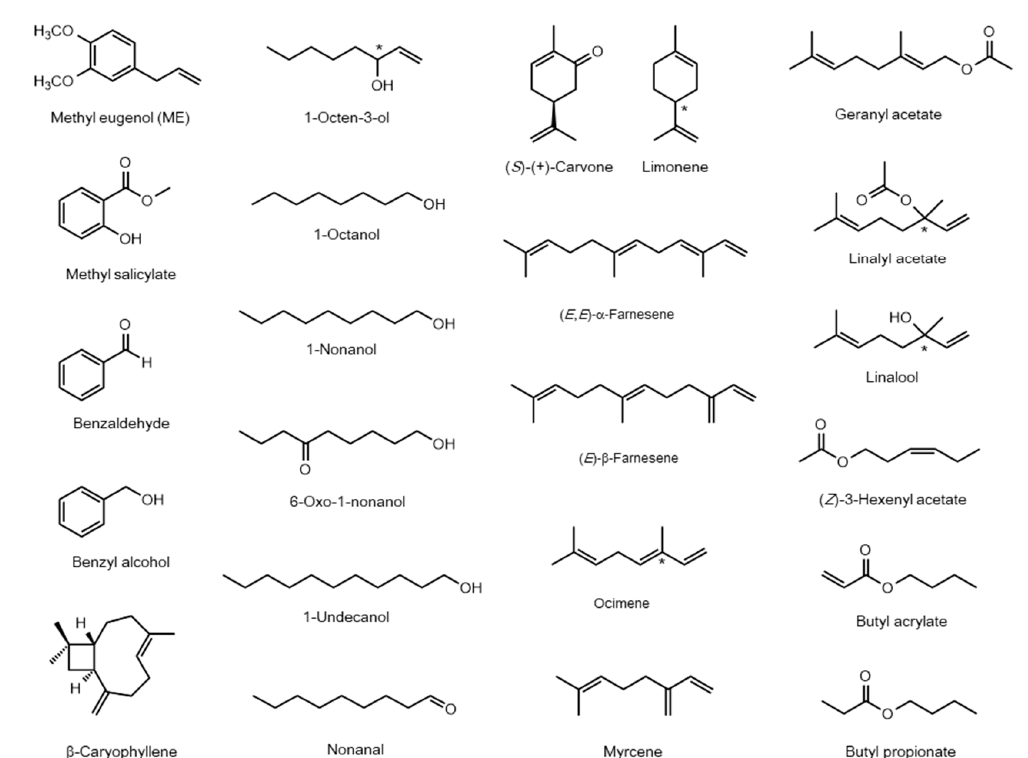
Figure 2. Structures of ligands for odorant biding proteins and olfactory receptors presented in Tables 1 and 2. Stereocenters are shown by asterisks.